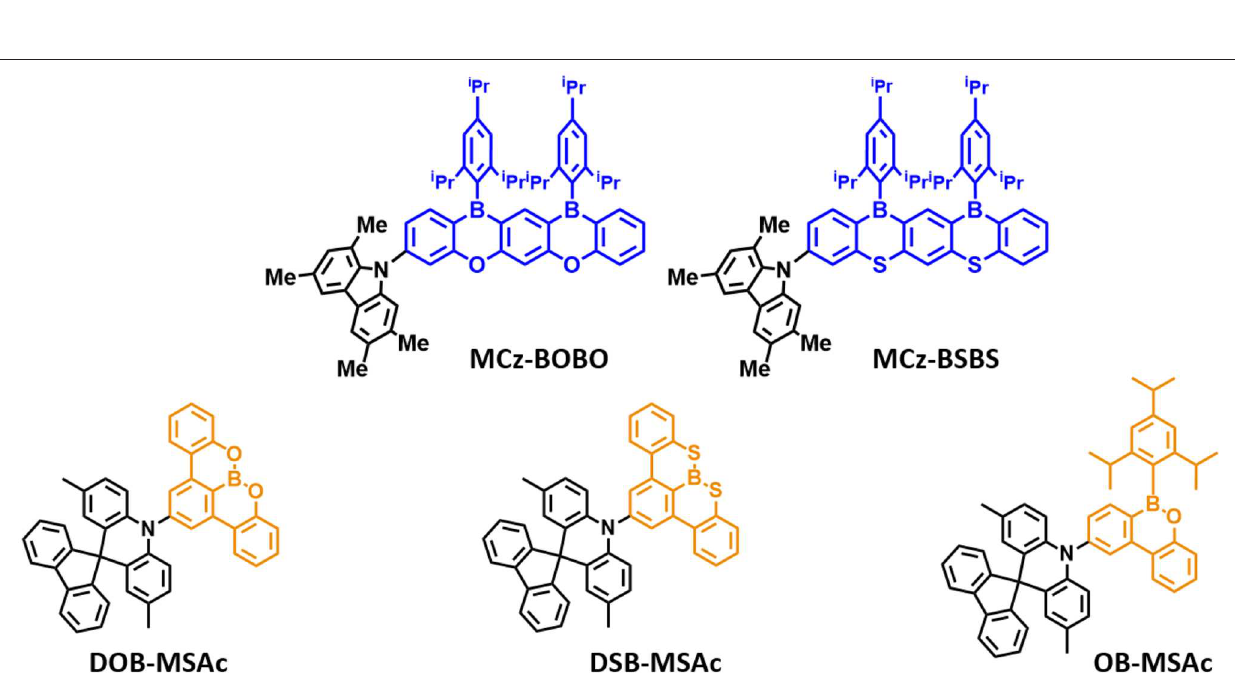
Frontiers in Chemistry |